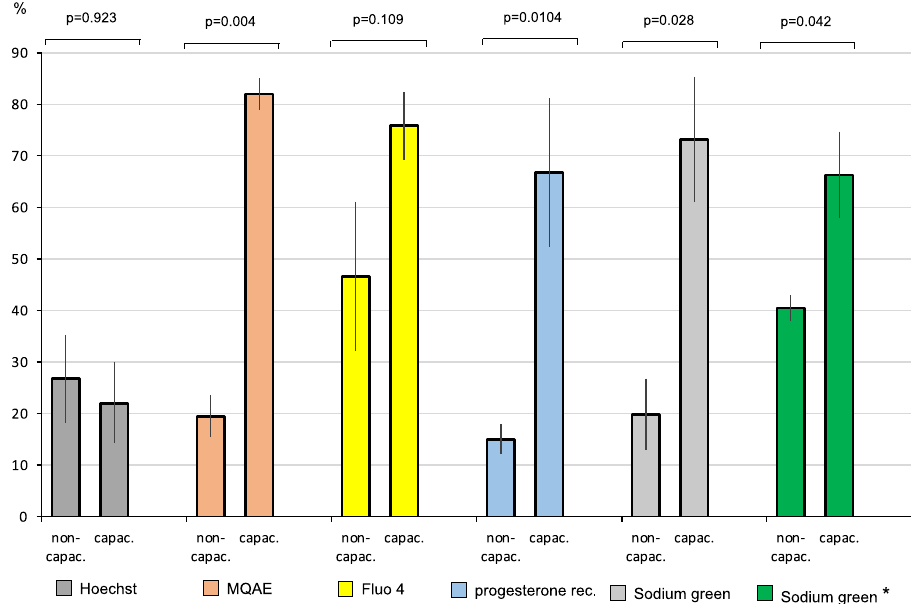
Figure 1. Results FC and sorting of 10,000 or more spermatozoa after incubation in either capacitating or non-capacitating culture medium. The following dyes were used to label the spermatozoa: Hoechst 33342-dye (negative control), MQAE, Fluo4, progesterone receptor-FITC and sodium green (CoroNa + ). For sorting the spermatozoa were provided by six fertile donors. Three additional sortings were performed using the sodium green dye using spermatozoa provided by three men heterozygous for the Phe508del variant of the cftr-gene (marked with an